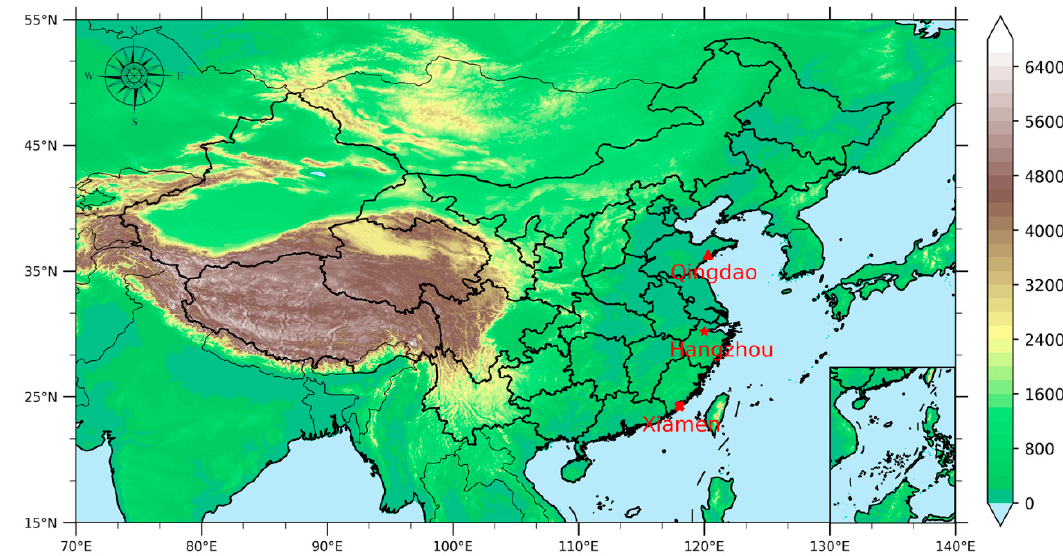
Figure 1. Locations of three metropolises along Eastern costal China. The altitude values are displayed in color.